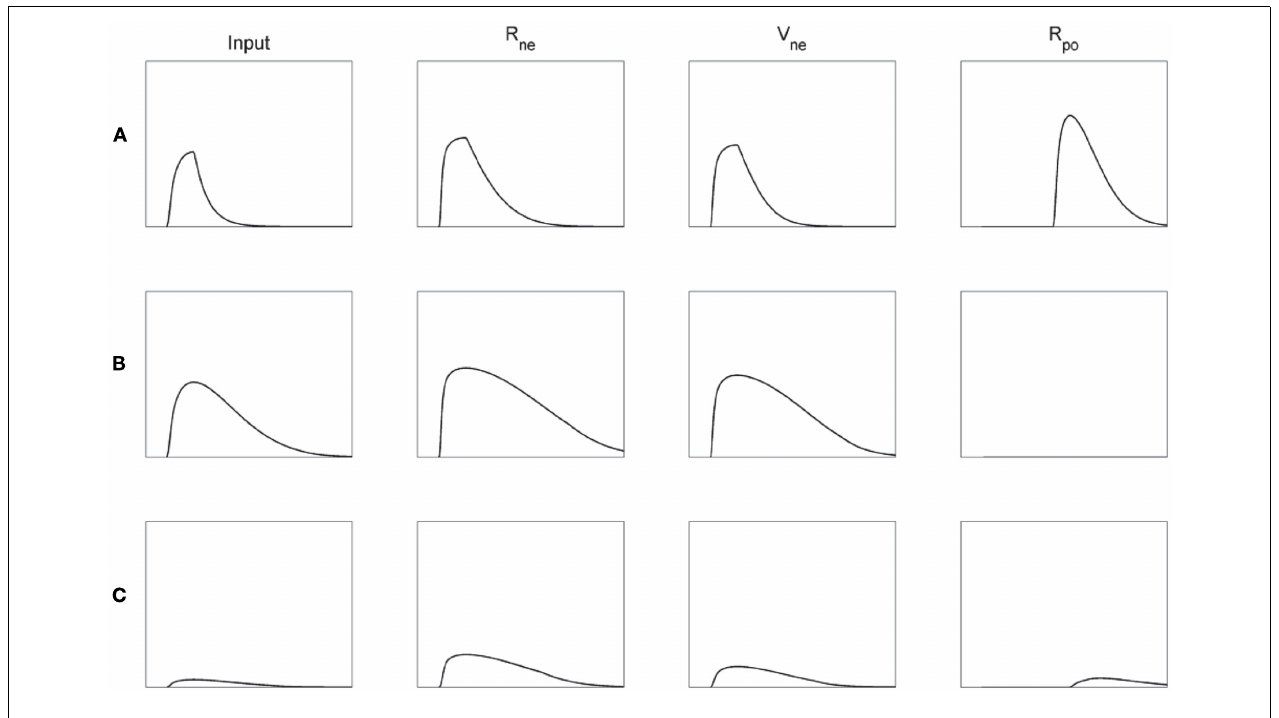
FIGURE 5 |Activation plots of the network presented in Figure 4. The left column depicts the input (i.e., level of competition in the module) to the R ne andV ne nodes, subsequent columns the R pe ,V ne , and R po activations, respectively. (A) Initially much competition arises due to the